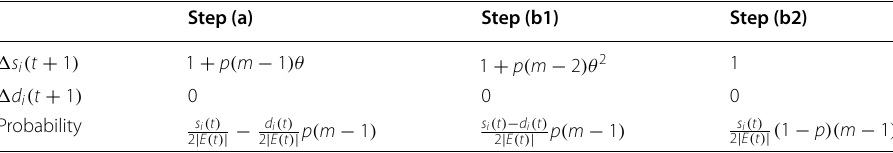
Table 4 The cases in which the degree of node v i does not